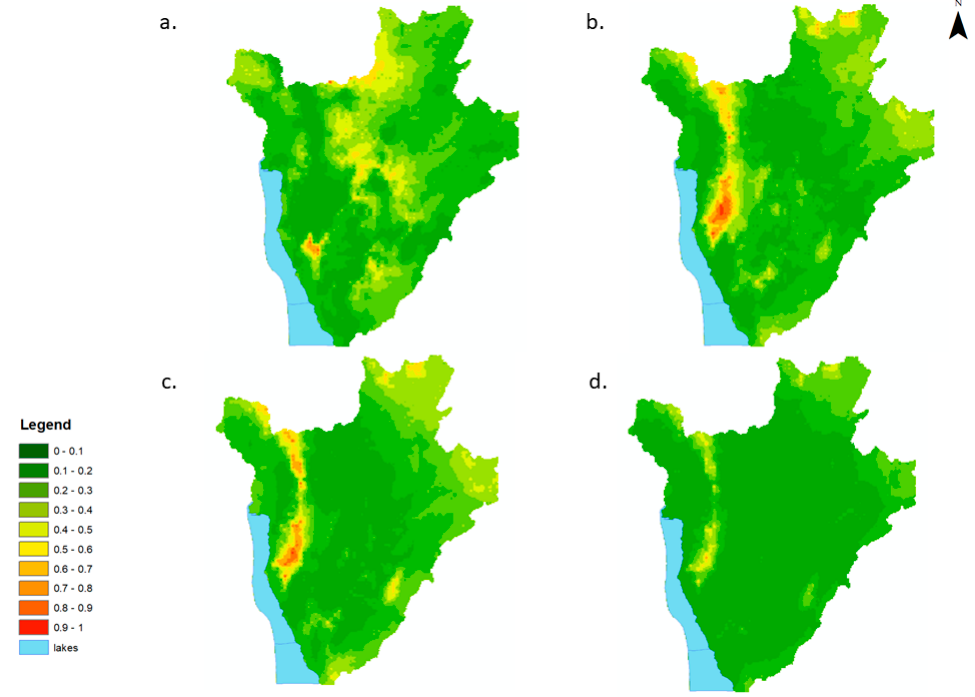
Figure 4. Predicted prevalence maps of moderate/high-severity anaemia per year for school-aged children (5–15 yrs) in Burundi, 2008–2011. ( a ) 2008, ( b ) 2009, ( c ) 2010, ( d ) 2011.